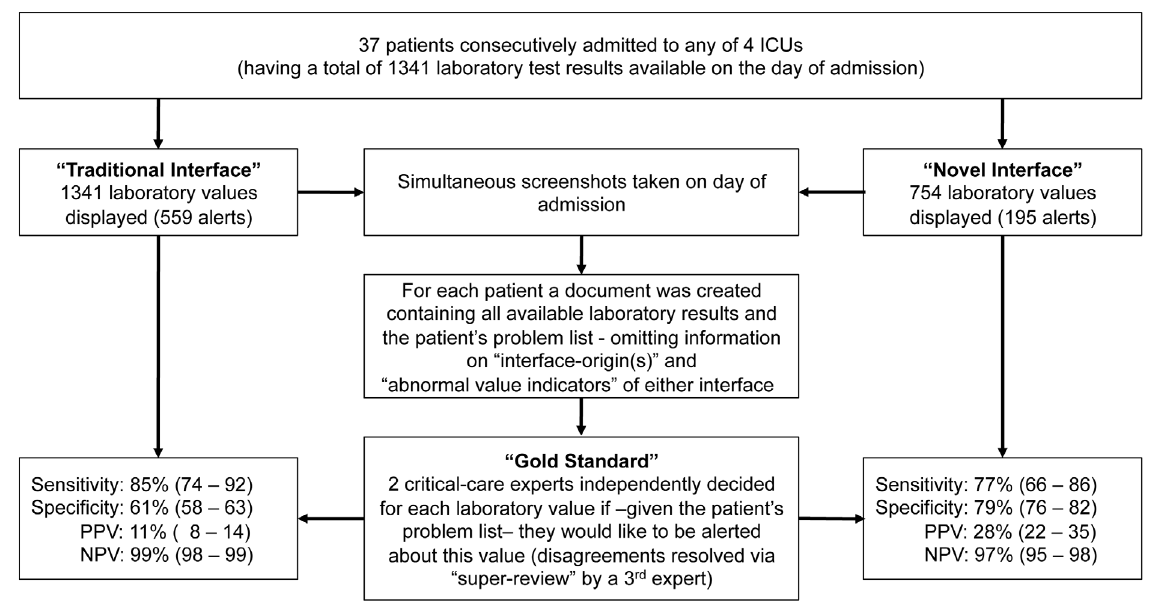
Figure 1. Studyflow and Results. Sensitivity, Specificity, Positive and Negative Predictive Values (PPV, NPV) are given as estimate (95%-Confidence Interval). Only specificity and negative predictive values differed significantly (for details see text).